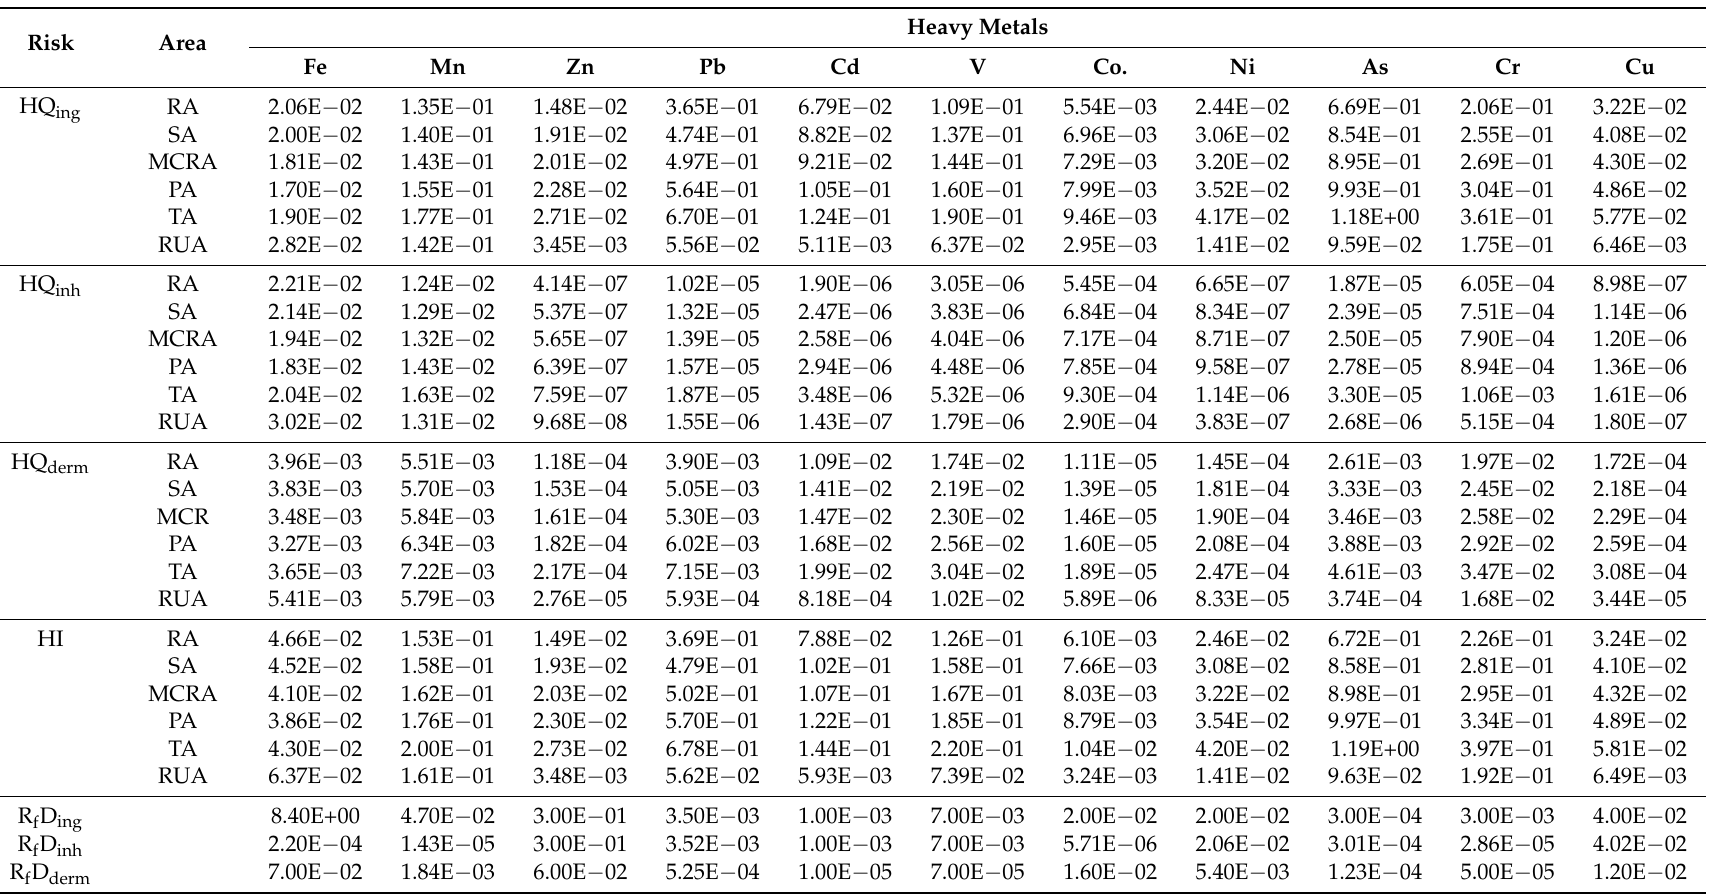
Table 6. Hazard quotient and hazard index of each heavy metal for children population living in different functional areas. Risk